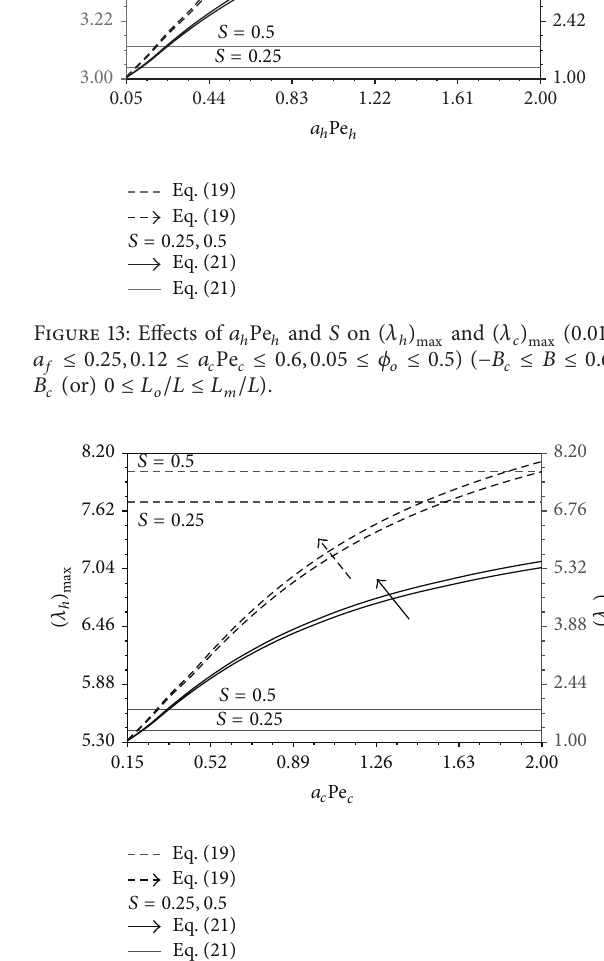
Figure 14: Effects of 𝑎 𝑐 Pe 𝑐 and 𝑆 on (𝜆 𝑐 ) max and (𝜆 ℎ ) max (0.01 ≤ ≤ 0.25, 0.05 ≤ 𝑎 𝑎 𝑓 ( or ) 0 ≤ 𝐿 𝐵 𝑐